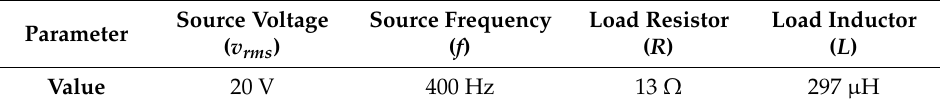
Table 3. Experimental parameters for the three-phase RL network.